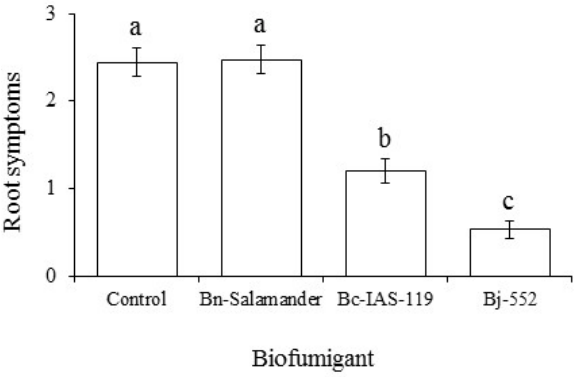
Figure 1. Average root symptom severity scores (and SE) for Lupinus luteus plants growing in soils infested with P. cinnamomi chlamydospores and biofumigated. Values with different letters differ significantly according with the Tukey´s HSD test ( P